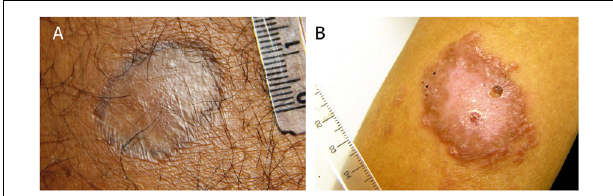
FIGURE 1 | Tegumentary leishmaniasis caused by Leishmania braziliensis . (A) Atrophic scar post a successful treatment; (B) lesion reactivation post treatment. Photos kindly provided by Dr. M. R. Lyra and LaPClin Vigileish - National Institute of Infectology Evandro Chagas -INI- Fiocruz.